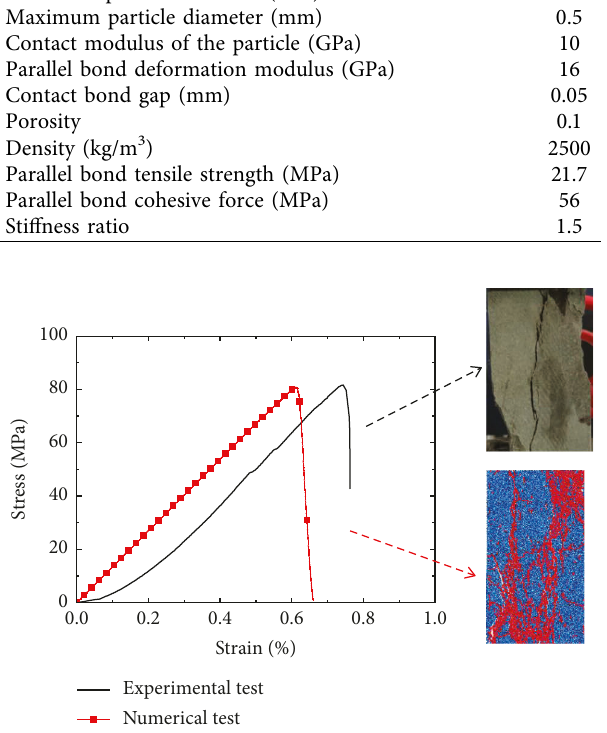
Figure 3: Comparison of experimental and numerical results of stress-strain curves and damage modes [14].